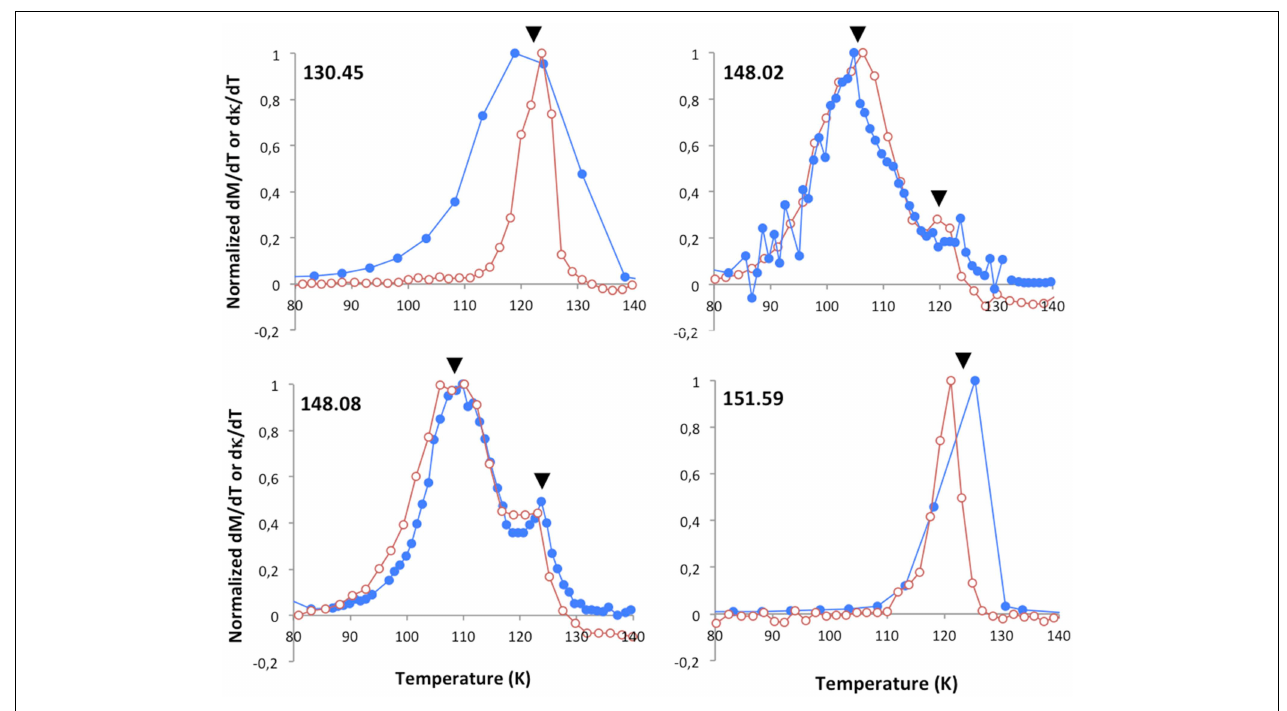
FIGURE 7 | Comparison of normalized derivative curves of low-temperature thermomagnetic measurements for samples 130.45, 148.02, 148.08, and 151.59 (plain circles: ZFC-derivative, empty circles: susceptibility-derivative). Arrows